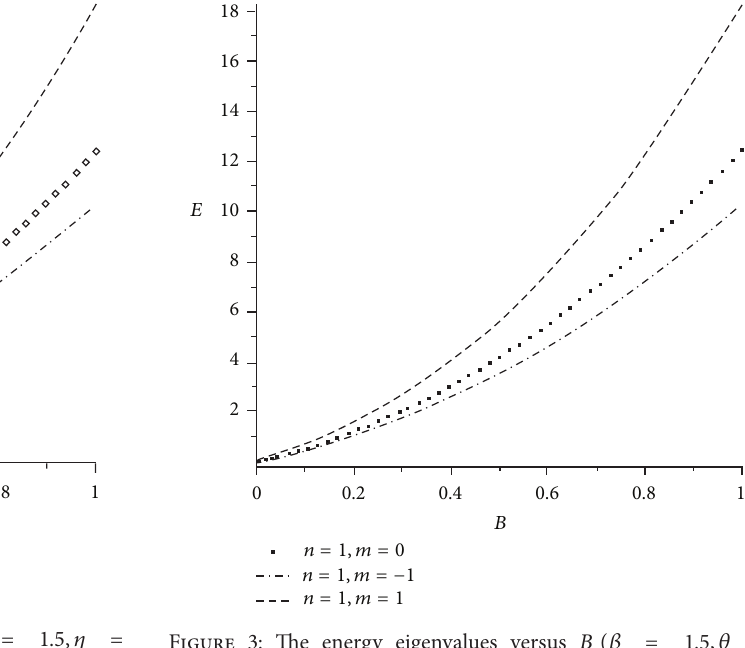
Figure 3: The energy eigenvalues versus 𝐵 (𝛽 = 1.5, 𝜃 = 0.000001, 𝑀 = 0.3) .